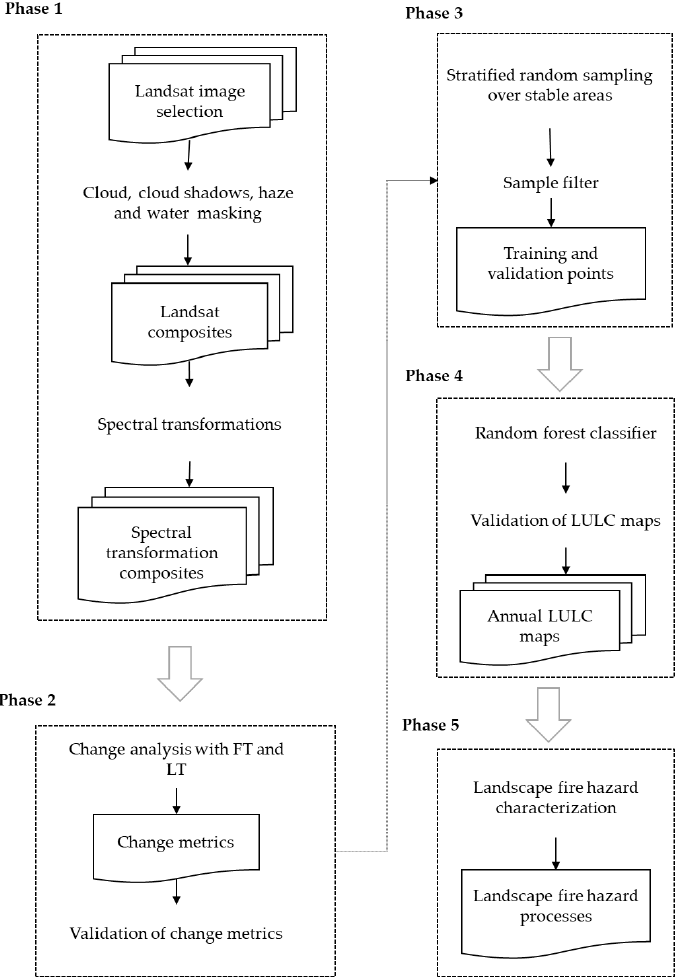
Figure 2. Methodological process diagram.